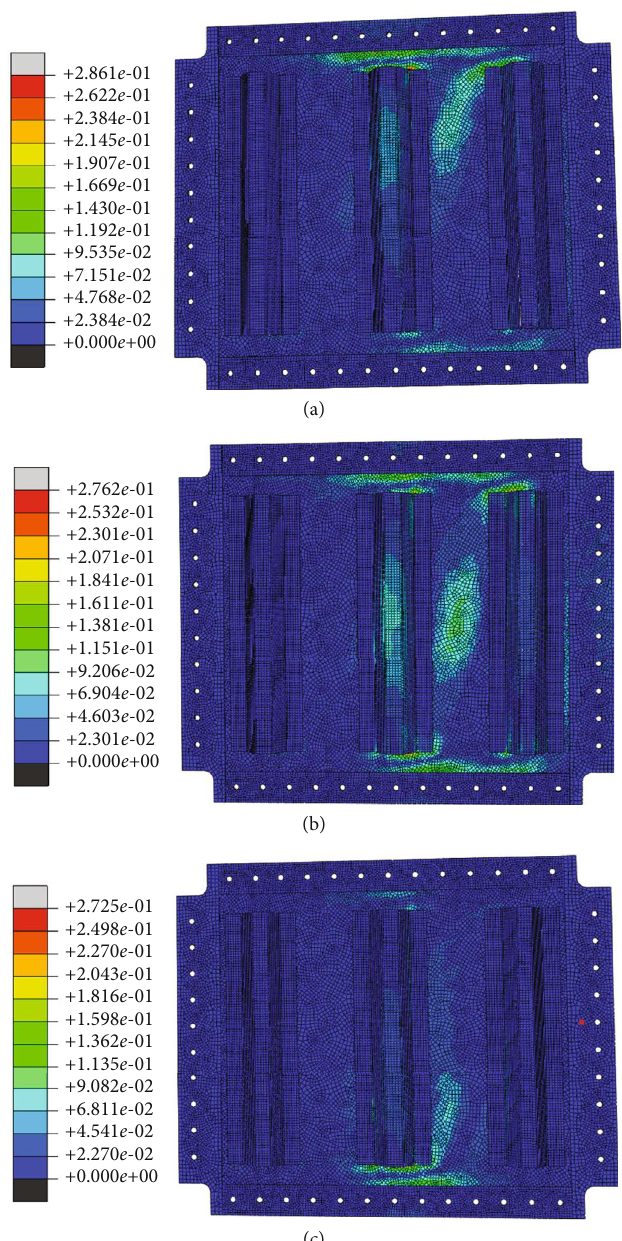
Figure 14: Tsai-Wu failure coe ffi cient of the composite-reinforced wall panels. (a) Impact point A. (b) Impact point B (c). Impact point C.